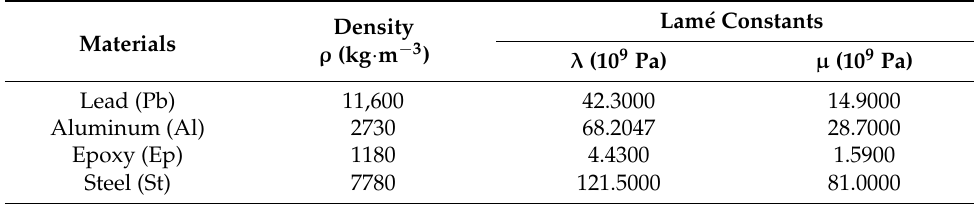
Table 1. The material parameters.